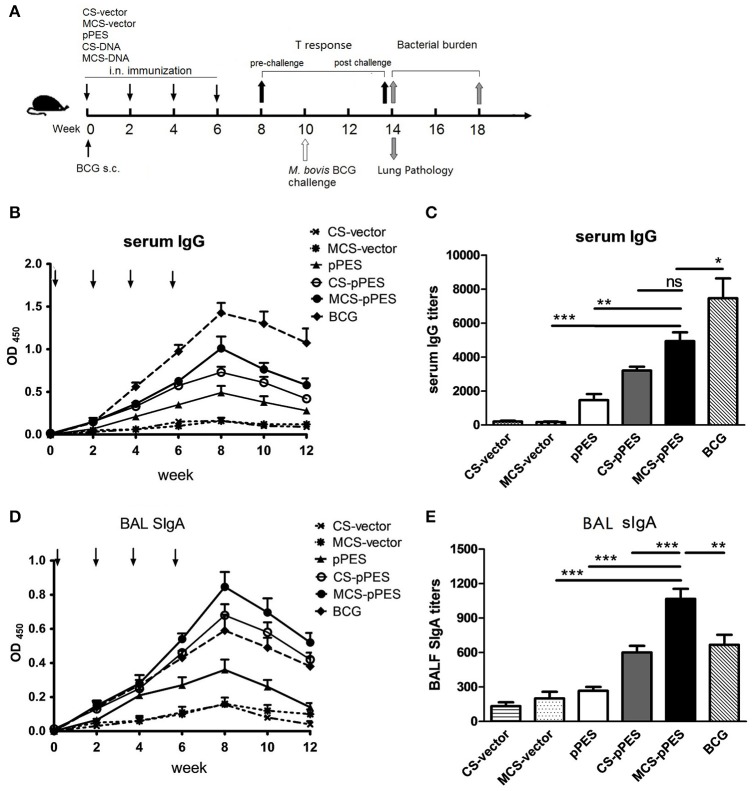
MCS-pPES intranasal immunization significantly enhanced HSP65-specific bronchoalveolar lavage fluid SIgA induction. (A) Schematic diagram of the time course of animal immunization and challenge regimen. Mice were intranasally immunized with 4 doses of MCS- or CS-DNA. One dose of 106 CFU BCG was subcutaneously injected into hind legs of mice. Levels and titers of HSP65-specific serum IgG (B,C) and bronchoalveolar lavage fluid SIgA (D,E) were detected by ELISA assays. Data are representative of three independent experiments and presented as the mean ± SEM (n = 6). *p < 0.05; **p < 0.01; ***p < 0.001; ns, not significant.